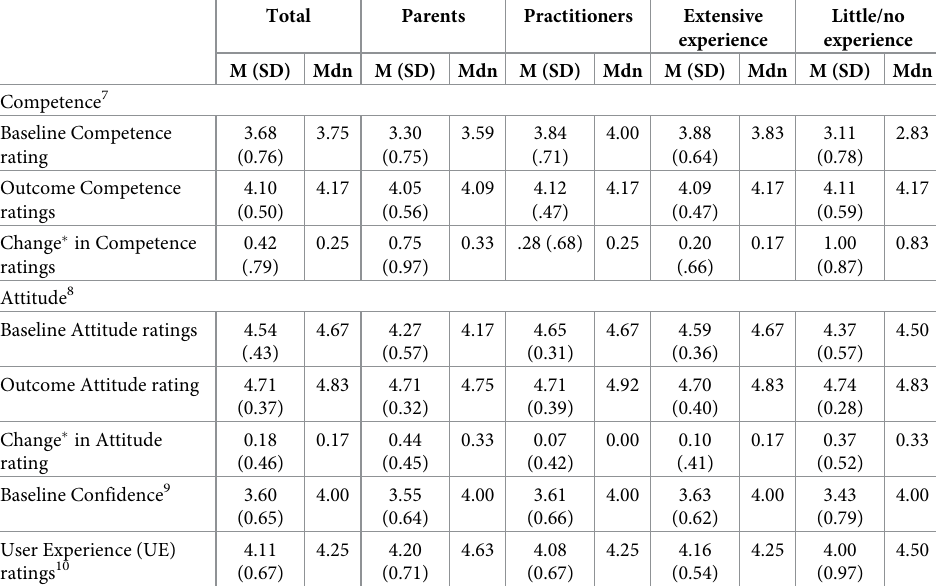
Table 3. Descriptive statistics of measures from participants who complete post-engagement survey (n = 48). Total